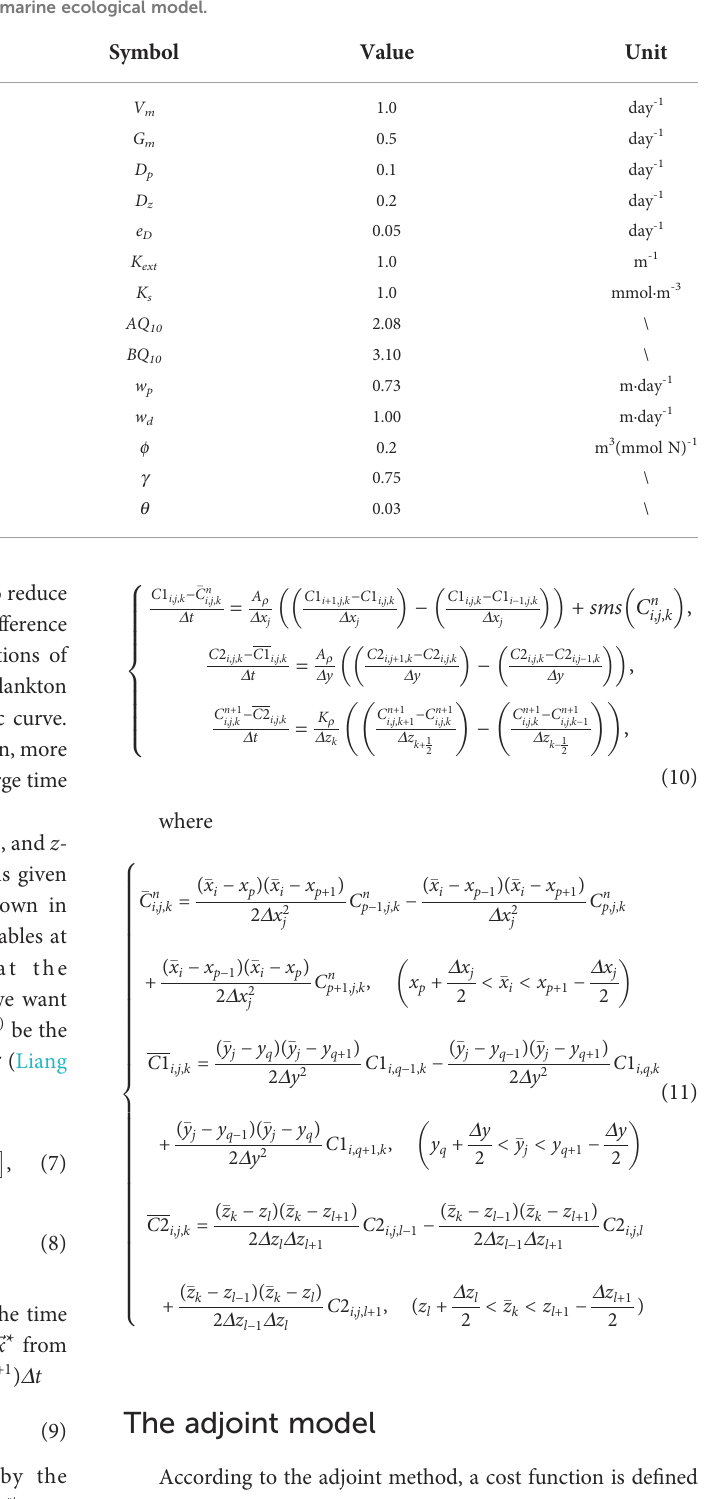
TABLE 1 The meaning and initial values of parameters in the marine ecological